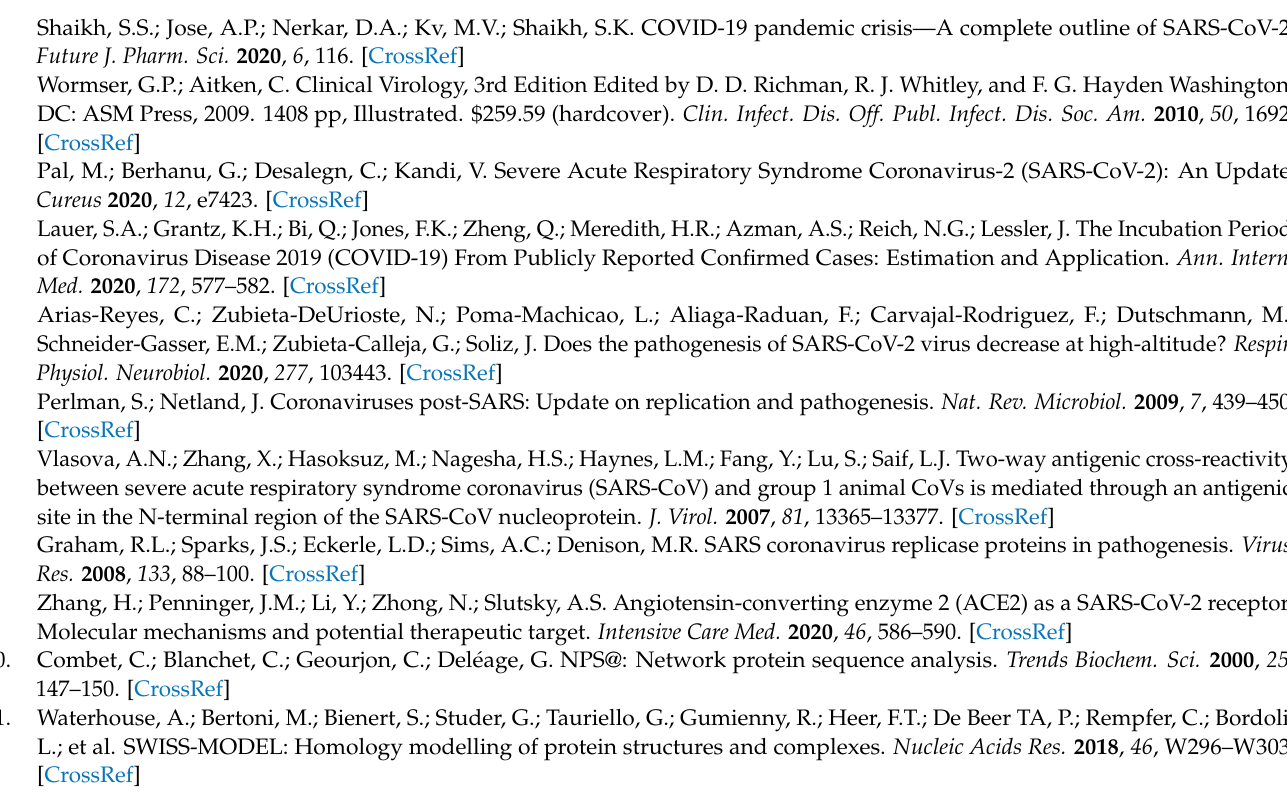
of the envelope protein of 1; Figure S2: Schematic view of contigs of the membrane glycoprotein of 1; Figure S3: Schematic view of contigs of the Nucleocapsid phosphoprotein of 1; Figure S4: Schematic view of contigs of the ORF10 protein of 1; Figure S5: Schematic view of contigs of the ORF1a polyprotein of 1; Figure S6: Schematic view of contigs of the ORF1ab polyprotein of 1; Figure S7: Schematic view of contigs of the ORF3a protein of 1; Figure S8: Schematic view of contigs of the ORF6 protein of 1; Figure S9: Schematic view of contigs of the ORF7a protein of 1; Figure S10: Schematic view of contigs of the ORF7b protein of 1; Figure S11: Schematic view of contigs of the ORF8 protein of 1; Figure S12: Viewer lays out predicted features of protein structural and functional features of Membrane Glycoproteins; Figure S13: Viewer lays out predicted features of protein structural and functional features of Nucleocapsid phosphoprotein; Figure S14: Viewer lays out predicted features of protein structural and functional features of ORF1a Polyprotein; Figure S15: Viewer lays out predicted features of protein structural and functional features of ORF1ab Polyprotein; Figure S16: Viewer lays out predicted features of protein structural and functional features of ORF7a protein; Table S1: Mutation of amino acids in Alpha & Delta Variant of SARs-CoV-2 from Pakistan with reference strain